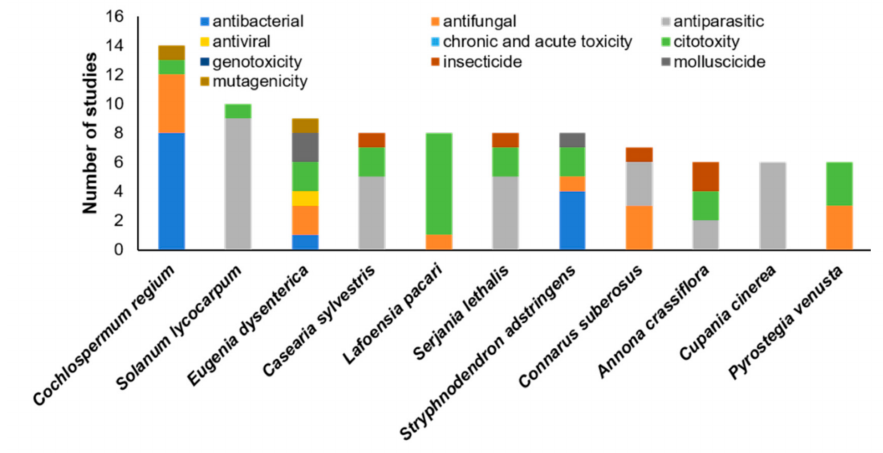
Figure 2. The bioactive properties of the Cerrado plant species that have been investigated in multiple studies. The most studied Cerrado species was Cochlospermum regium , while Eugenia dysenterica had the most diverse bioactive